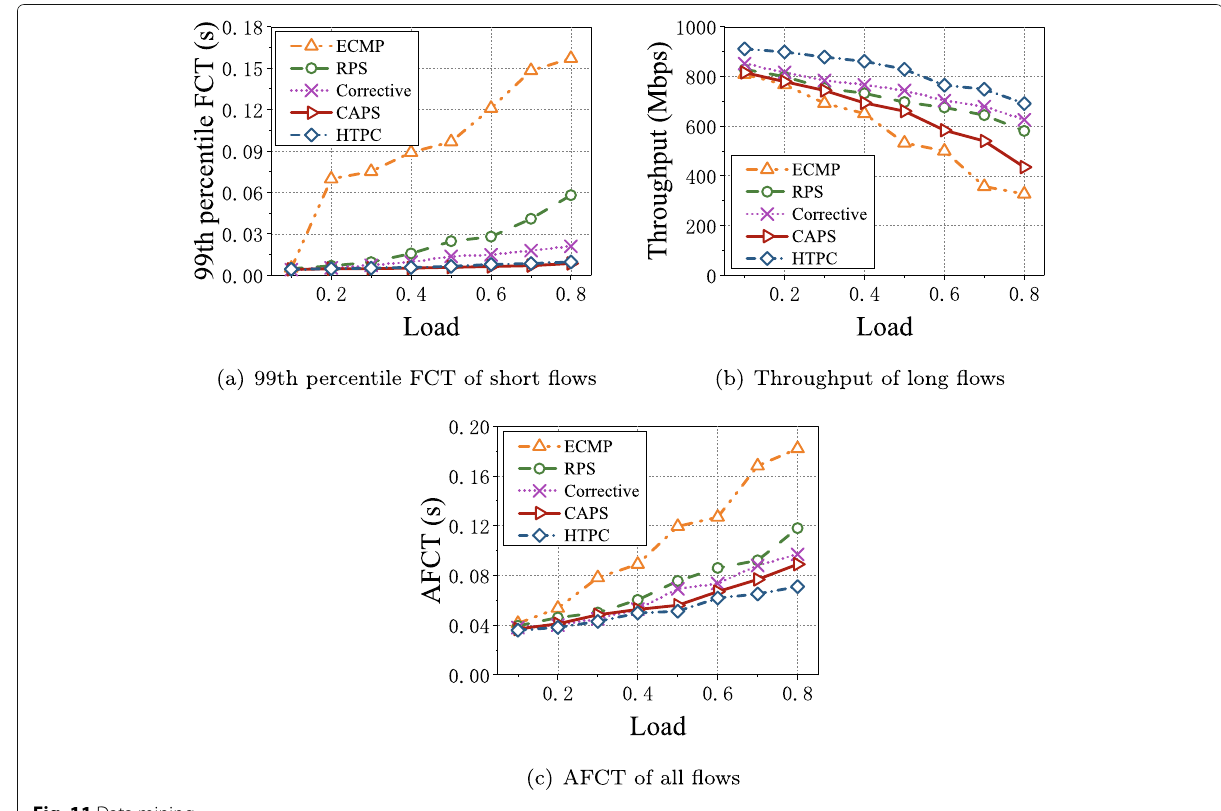
Fig. 11 Data mining